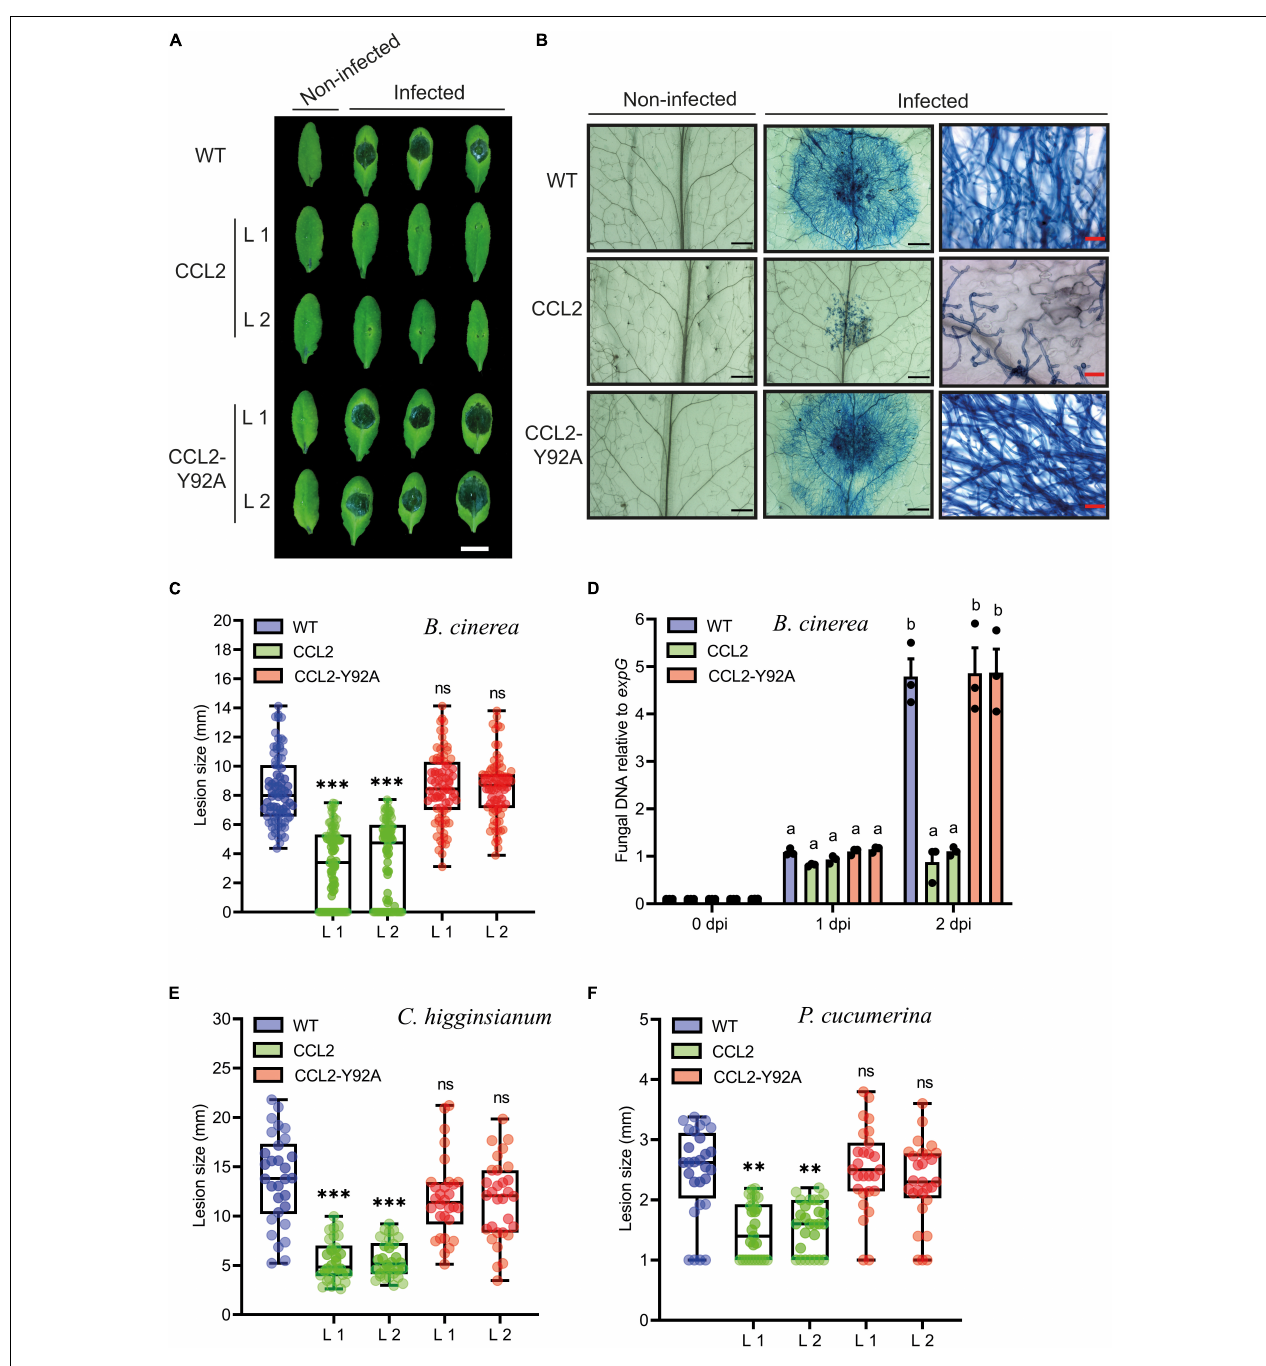
FIGURE 3 | Resistance of CCL2-expressing plants toward fungal pathogens. (A) Necrotic lesions caused by B. cinerea infection on leaves of 4-week-old WT, CCL2- and CCL2-Y92A lines inoculated with 6 µ L droplets of a spore suspension (5 × 10 4 spores mL − 1 ). Plants were photographed 3 dpi. Size bar = 1 cm. (B) Trypan Blue-staining of Arabidopsis leaves 60 hpi. The right-side shows close-up images. Black or red size bares are 1 mm and 50 µ m, respectively. (C) Quantification of lesion size at 3 dpi. Boxplots represent median and 1.5 times the interquartile range ( n = 80 from three independent experiments). (D) Quantification of fungal DNA by qPCR at 0, 1, and 2 dpi. The fungal Cutinase A gene (Genebank: Z69264) was quantified relative to expG gene (AT4G26410) of Arabidopsis. Bars represent mean values ± SE from three independent experiments. (E) Analysis of lesion size of 5-week-old WT and transgenic CCL2 lines droplet-inoculated with C. higginsianum (10 µ L of 2 × 10 6 spores mL − 1 per leaf). Plants were analyzed 10 dpi. (F) Analysis of lesion size of 4-week-old WT and CCL2 lines, droplet-inoculated with P. cucumerina (10 µ L of 5 × 10 6 spores mL − 1 per leaf). Plants were analyzed 5 dpi. Boxplots (E,F) represent median and 1.5 times the interquartile range ( n = 30 from three independent experiments). The data was analyzed by one-way ANOVA and post hoc analysis by Dunnett’s multiple-comparison test. Asterisks show a statistically significant difference between the CCL2 expressing lines and WT plants ( ∗∗∗ P ≤ 0.001, ∗∗ P ≤ 0.01, ns, not significant). The letters a and b signify a between-group difference at the P ≤ 0.05